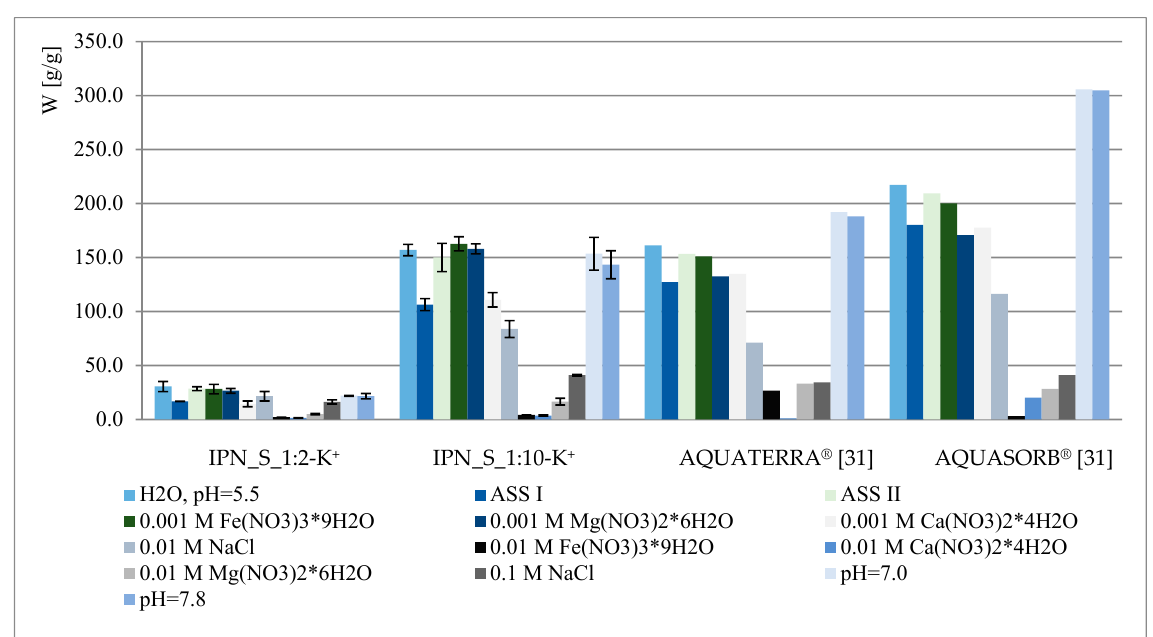
Figure 4. Swelling properties of chosen IPNs and commercial hydrogels under different conditions.